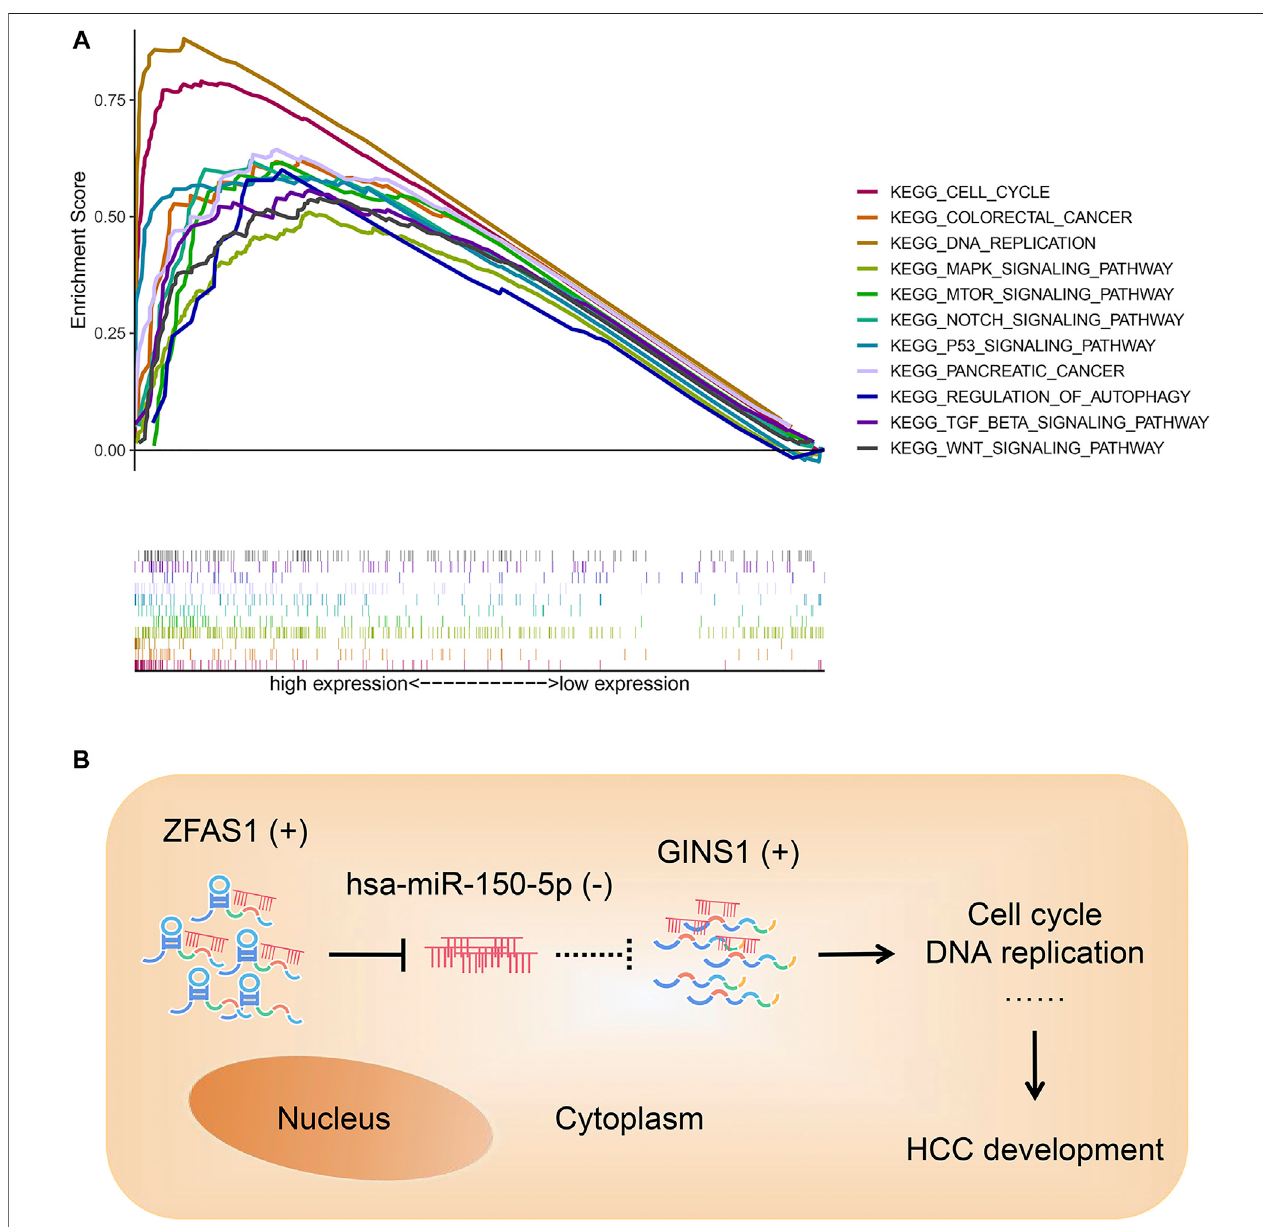
FIGURE10| GSEAanalysisofGINS1 (A) andconceptualmapofthemechanismofZFAS1/hsa-miR-150-5p/GINS1axis (B) .InthecytoplasmofHCCcell,lncRNA ZFAS1 could act as a sponge to bind and negatively regulate the expression of miRNA hsa-miR-150-5p. Then miR-150-5p-mediated suppression of target mRNA was relievedandGINS1continuedtoexertanoncogenicroleinthedevelopmentofHCC.GSEA,genesetenrichmentanalysis;HCC,hepatocellularcarcinoma;lncRNA,long non-coding RNA; miRNA, microRNA; mRNA, messenger RNA; KEGG, Kyoto Encyclopedia of Genes and Genomes; (+), upregulated; ( − ), downregulated.